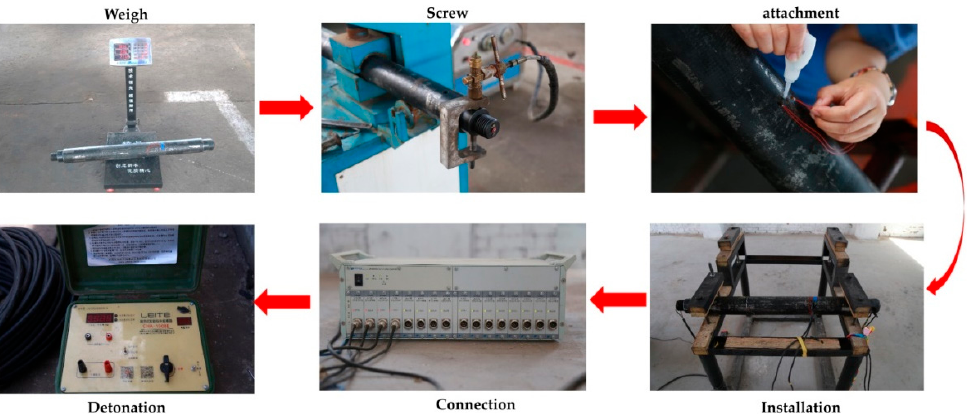
Figure 3. The experimental filling-blasting process.